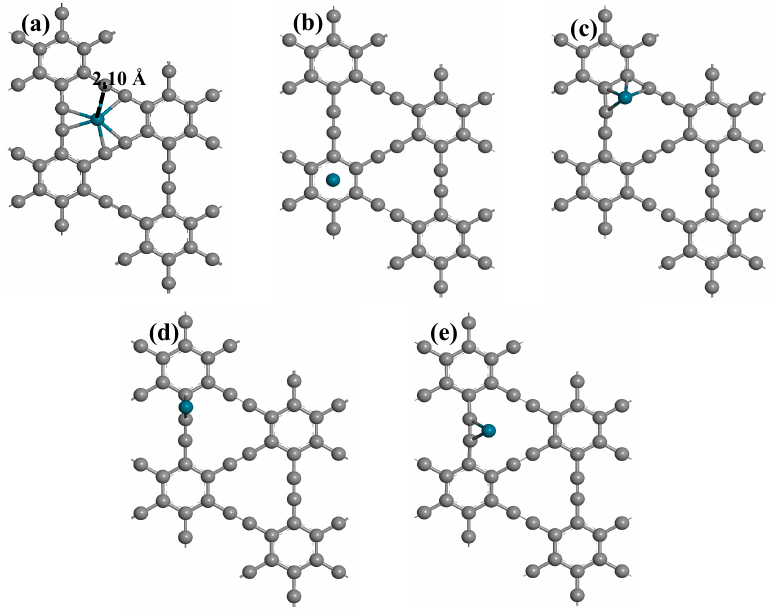
Figure 2. Optimized geometric structures of one Pd atom adsorbed on graphyne: ( a ) H1 site; ( b ) H2 site; ( c ) B1 site; ( d ) B2 site; ( e ) B3 site.